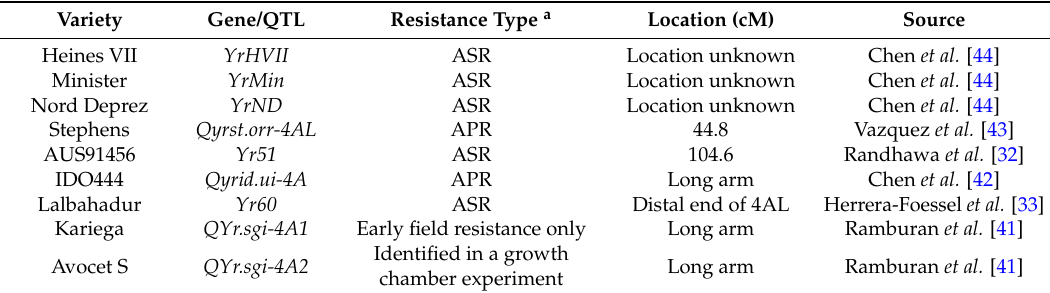
Table 4. Varieties containing stripe rust genes/ quantitative trait loci (QTL) on chromosome 4A. The resistance type APR (adult plant resistance) or AS (all stage resistance). Gene/QTL name and location are listed for each of the